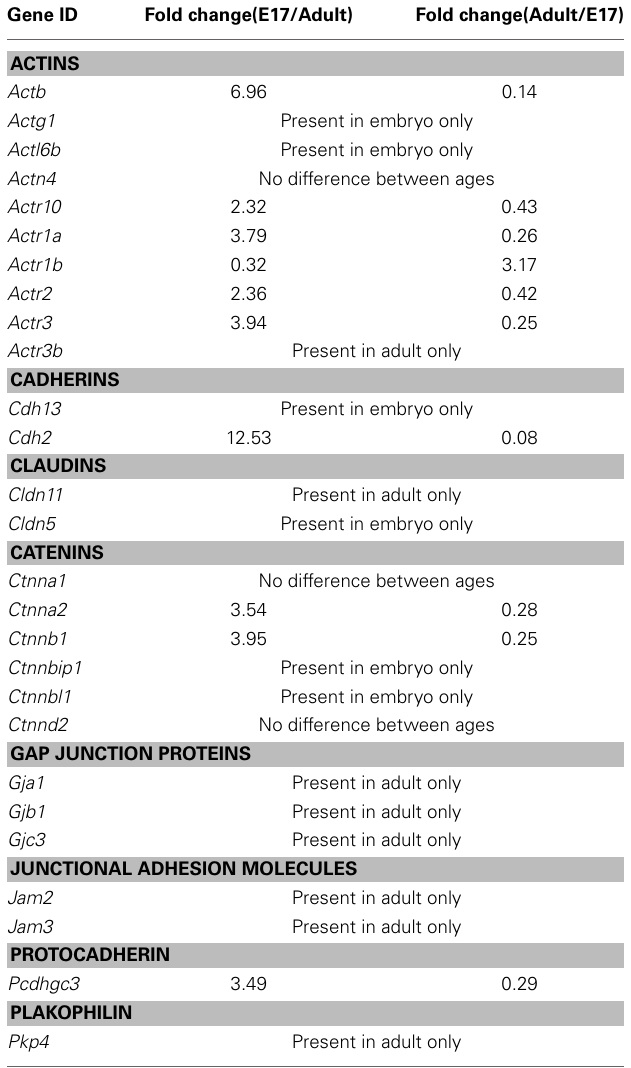
Table 4 | Gene expression of junction related genes in embryonic ventricular zone and adult ventricular ependyma.